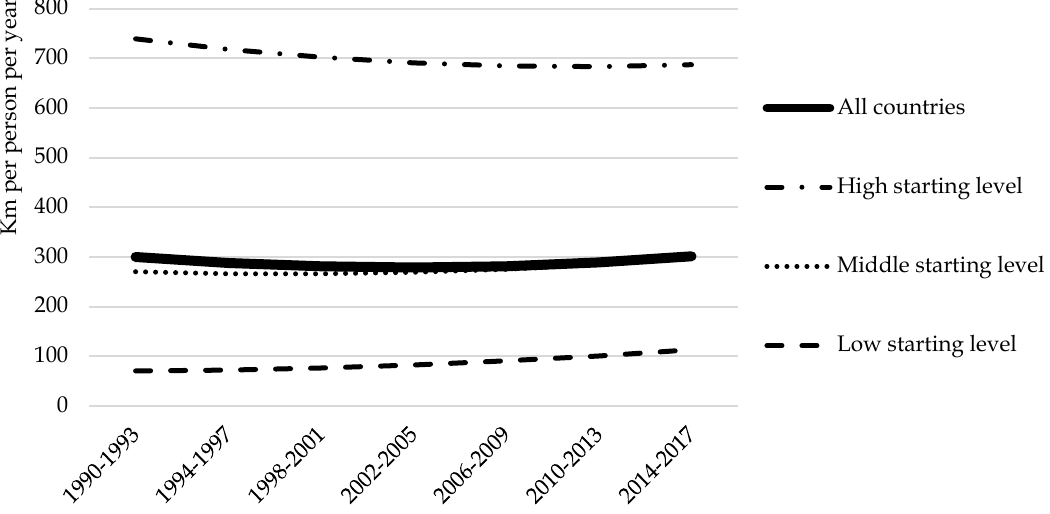
Figure 4. The development of distance cycled per capita per year in European countries between 1990 and